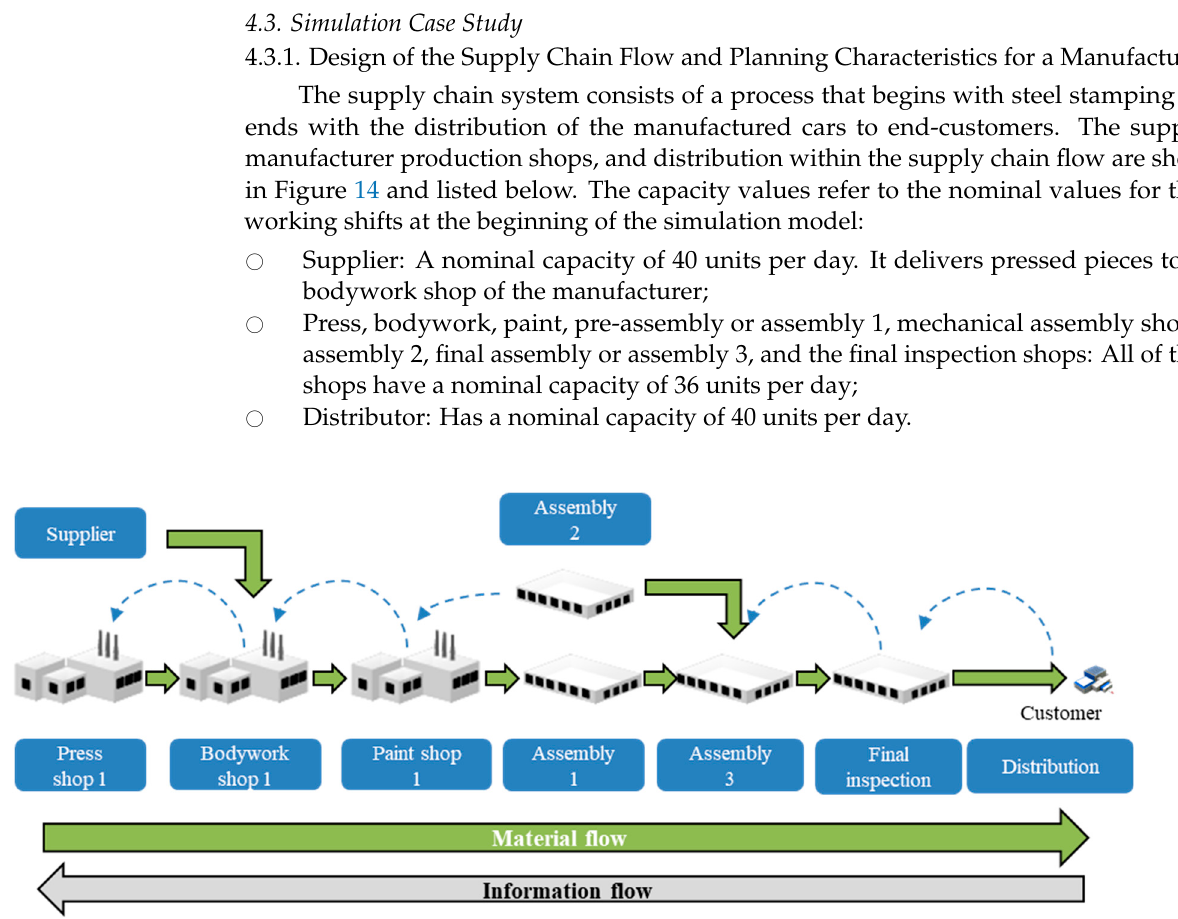
Table 6. Demand patterns, periods, and methods for random number generation.